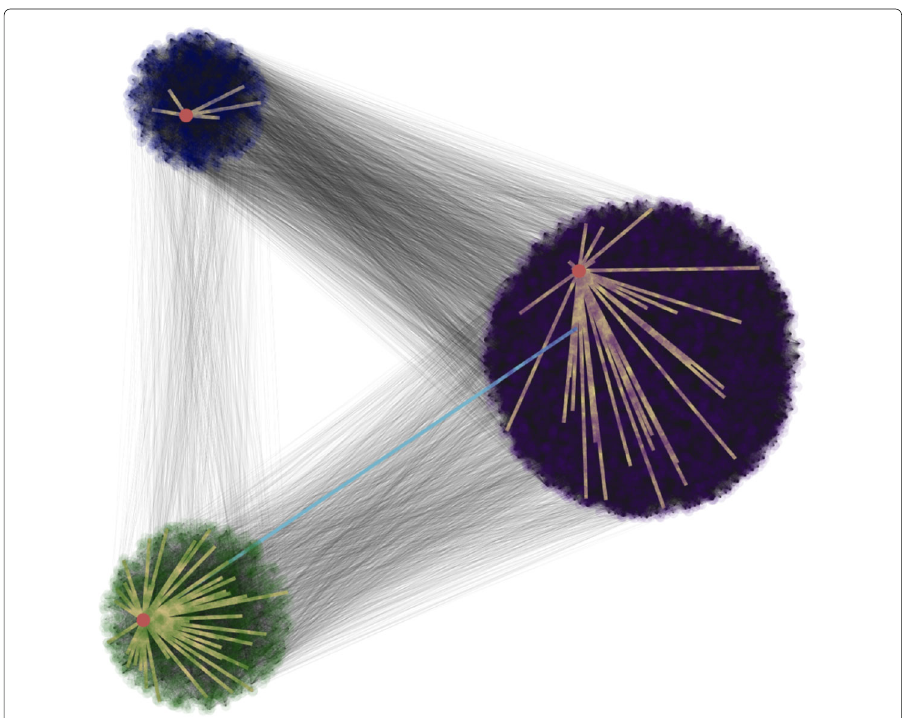
Fig. 2 Empirical three-cluster Social-Hash network qrs . See the text of the “Networks used in simulations” section and Tables 1 and 2 for details about the Social-Hash clusters. In each cluster, we highlight one person in red; we color that person’s within-cluster links yellow and out-of-cluster links light